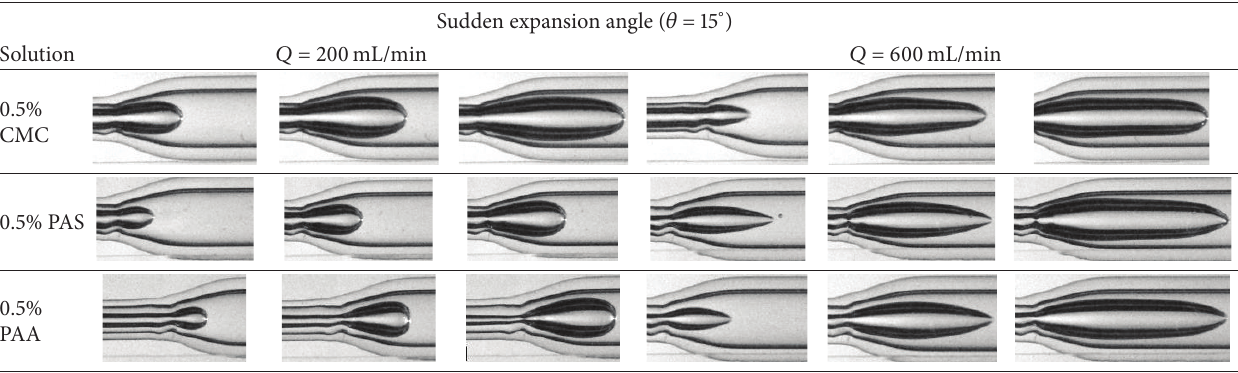
Table 5: Evolution of bubble contours for sudden expansion angle 𝜃 = 15 ∘ .